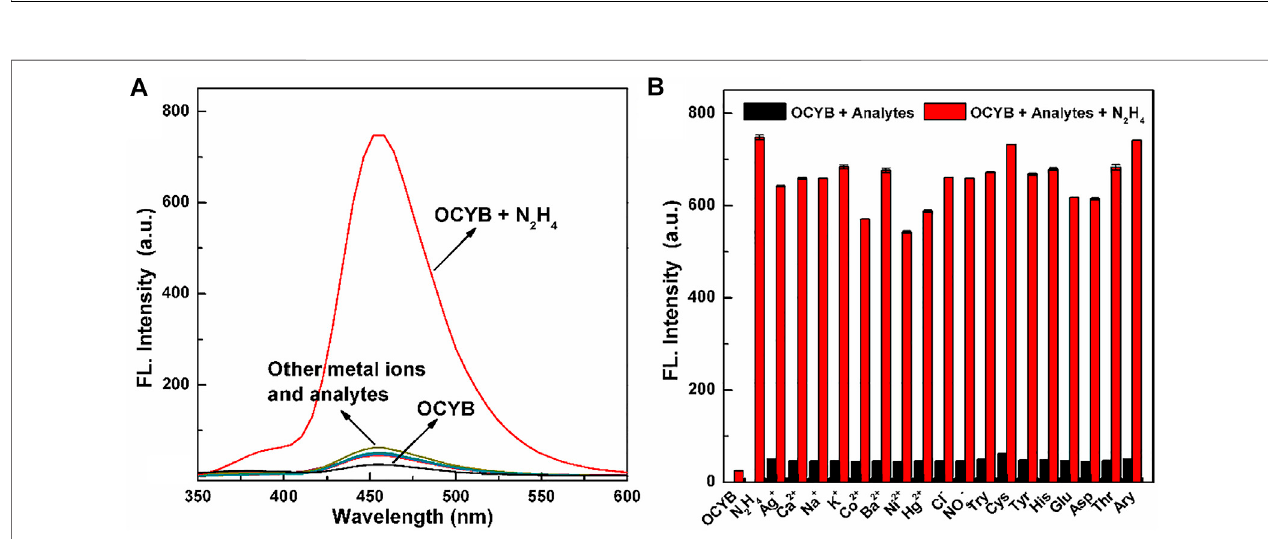
FIGURE 2 | Fluorescence spectra (A) of OCYB (10 μ M) in the presence of different interference analytes. (B) The fl uorescence intensity of OCYB and N 2 H 4 (200 μ M) in the presence of other interference analytes (200 μ M) in DMSO-HEPES buffer solution (1:1, v/v, pH 7.4, λ ex = 330 nm). Data are shown as the means ± SE (bars) ( n =